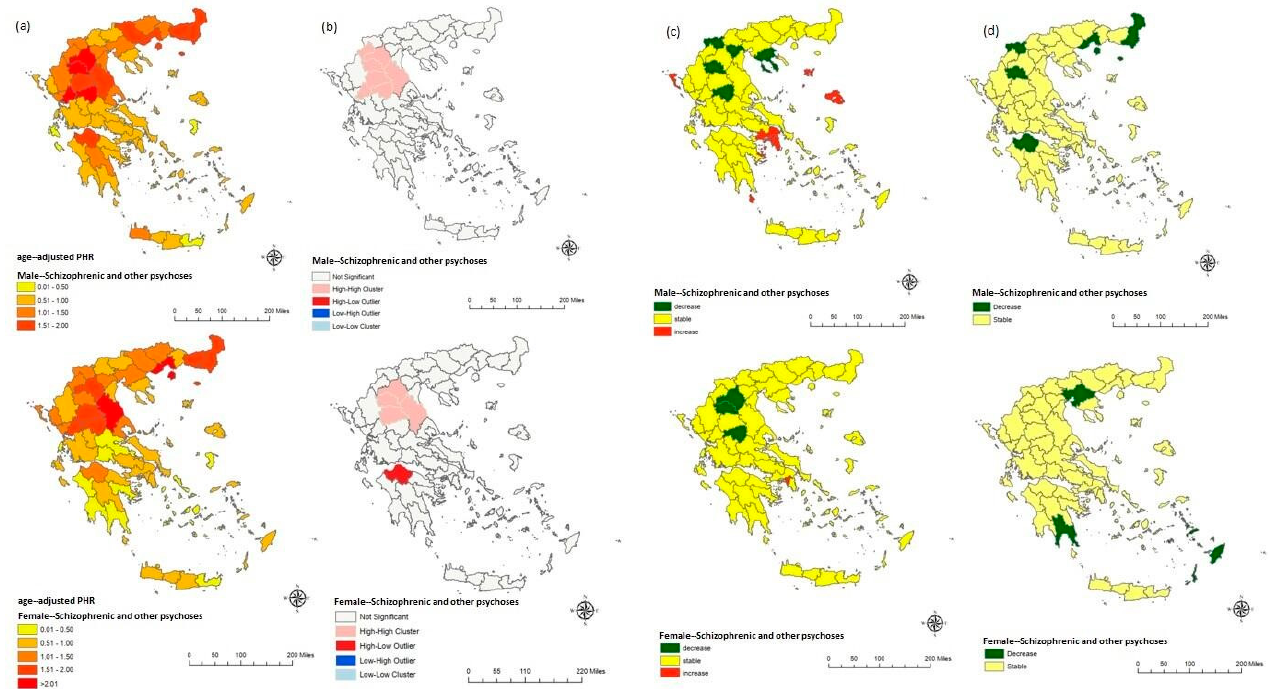
(Figure 1d). Among the HH cluster prefectures in females, Grevena and Kozani were those with decreased statistically significantly age-adjusted PHR values (Figure 1c).